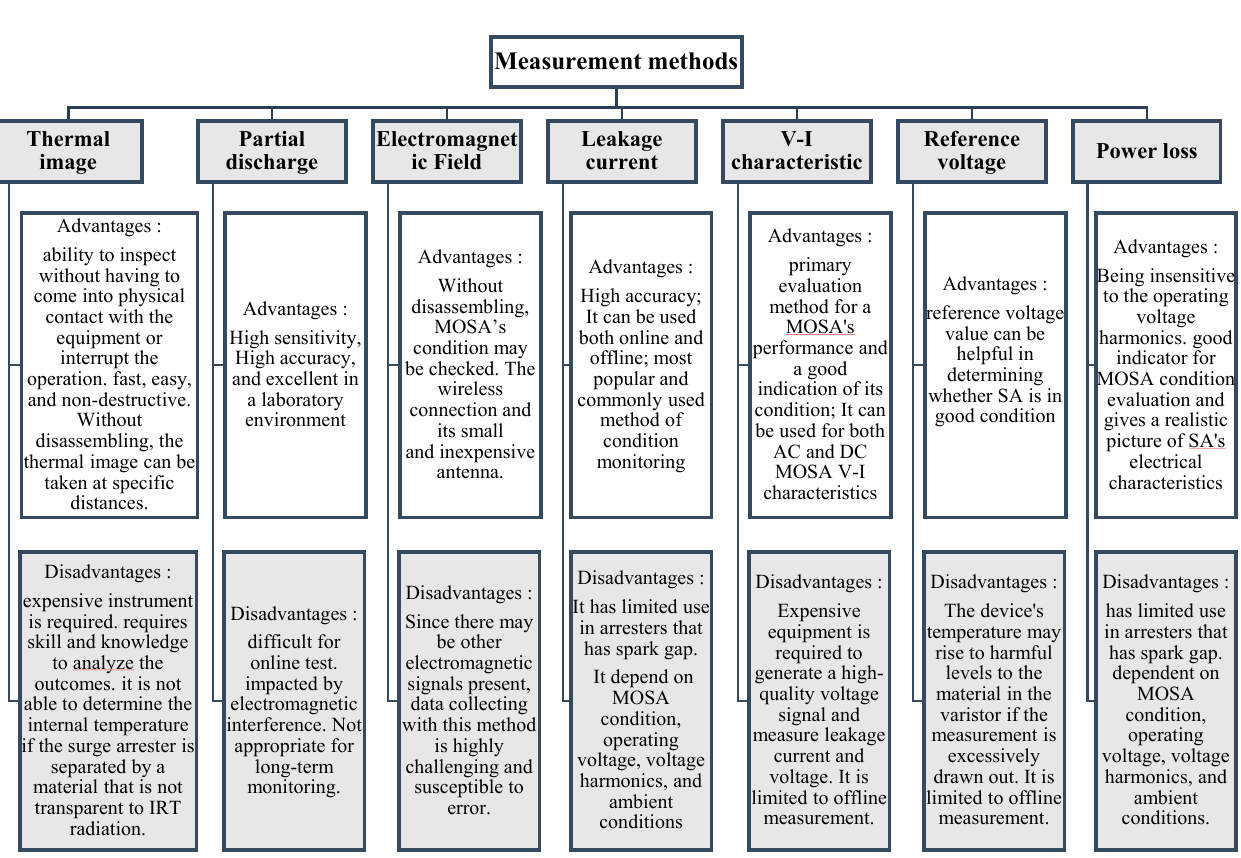
Figure 9. Advantages and disadvantages of MOSA diagnostic methods. Table 2. Comparison of properties, advantages, and disadvantages of MOSA diagnostic methods in different papers.